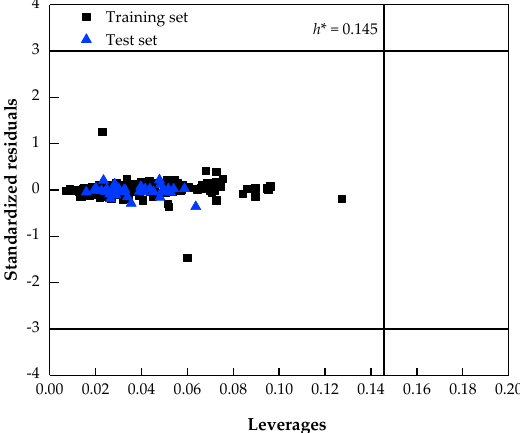
Figure 5. The Williams plot describing the applicability domain of the best model ( h *=0.145).